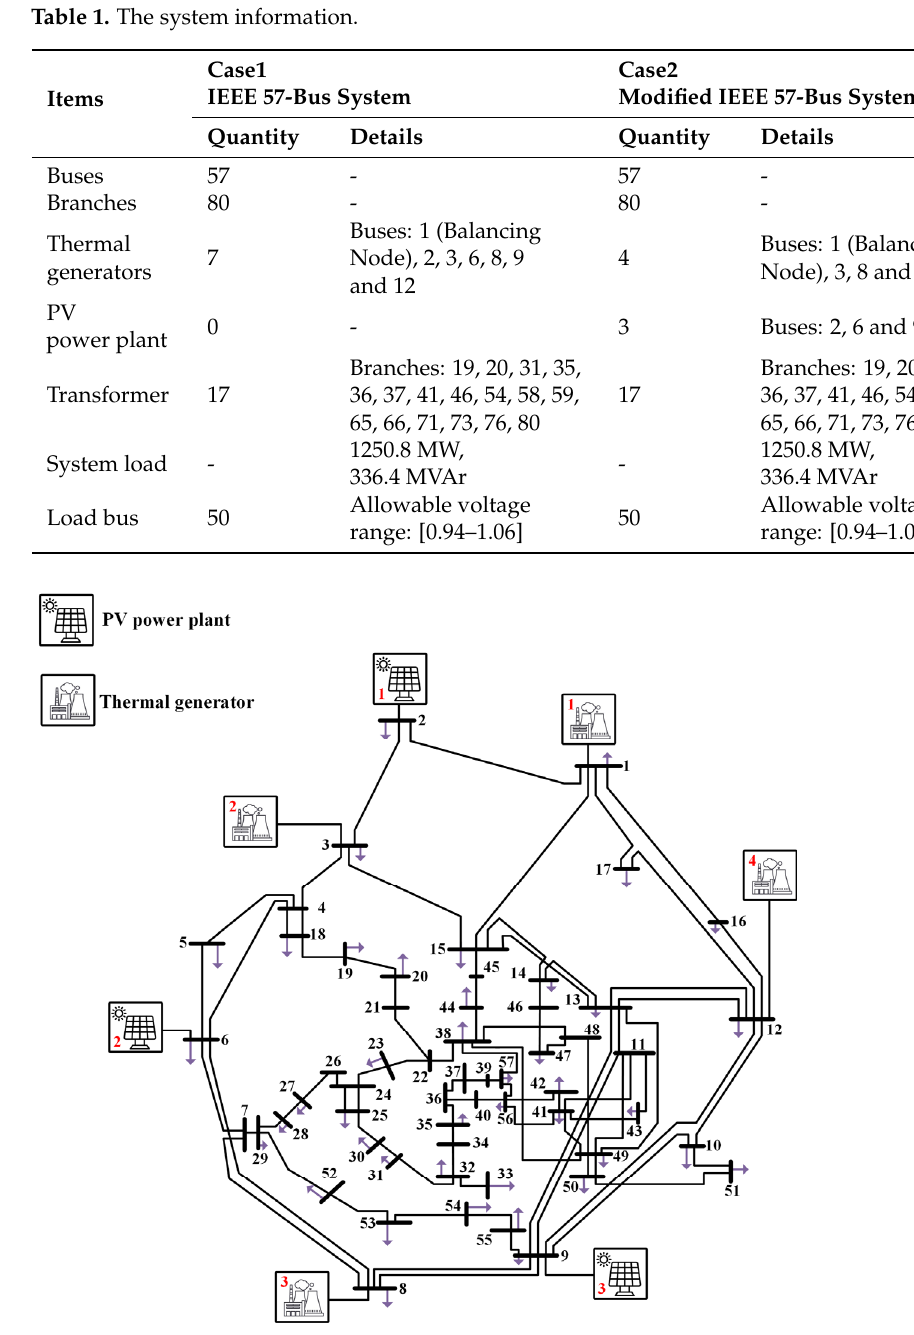
Figure 4. The wiring diagram of the modified IEEE 57-bus system (red 1 to 4 — power sources, black 1 to 57 — buses). Table 2. The parameters of the three solar photovoltaic